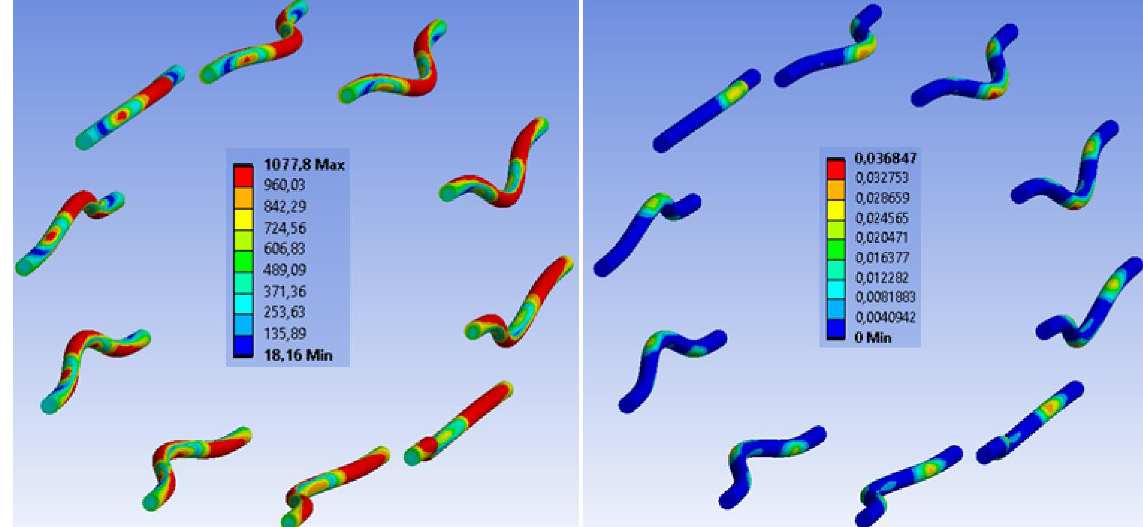
19 of 25 Figure 28. Deformation of a fully threaded screw (mm).